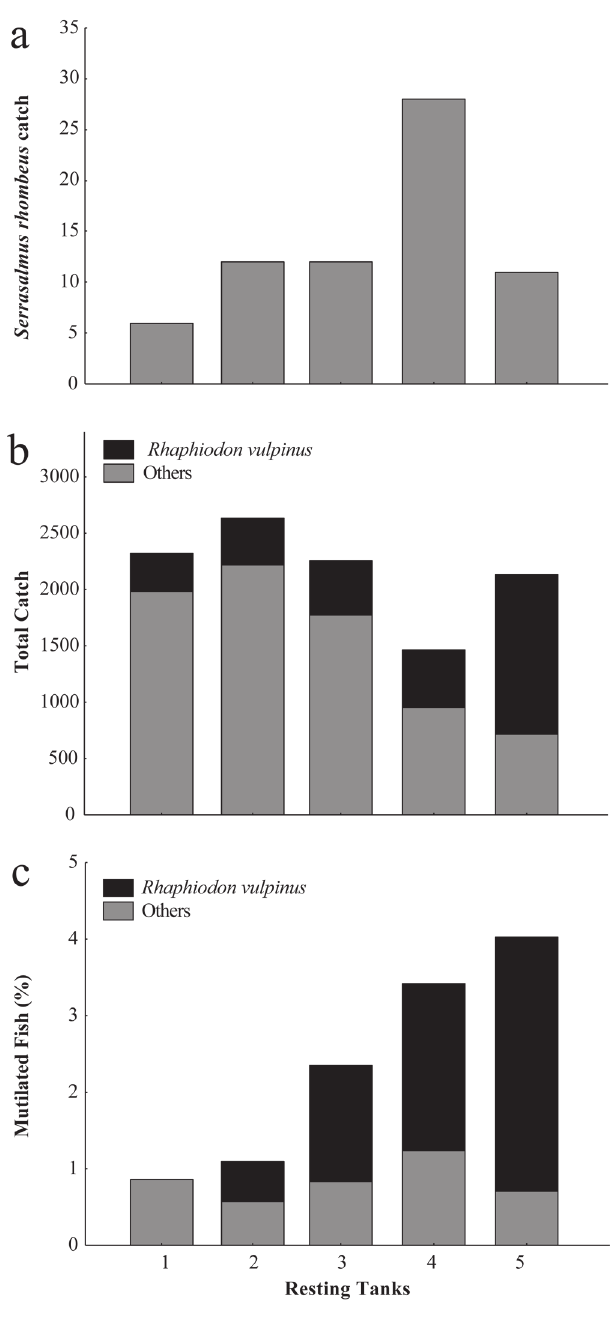
Fig. 3. Number of piranhas Serrasalmus rhombeus ( a ), total number of captured fish ( b ), and percentage of mutilated fish ( c ) in the resting tanks of the Lajeado Dam fish ladder. Rhaphiodon vulpinus is highlighted once this species had the greatest number of individuals